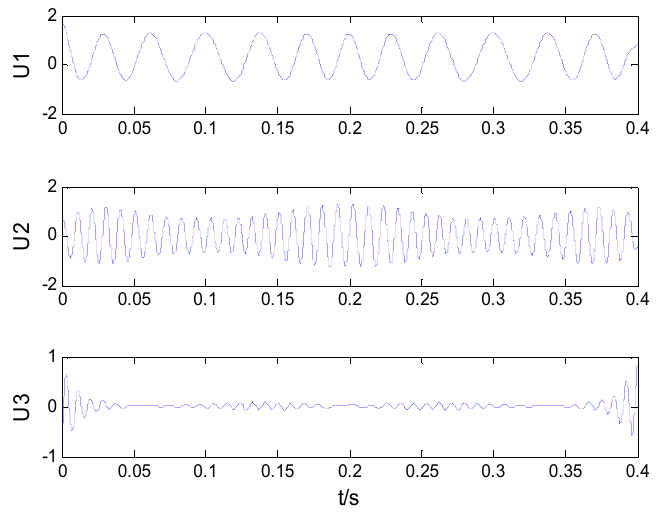
Figure 1. VMD results of the simulated signal.